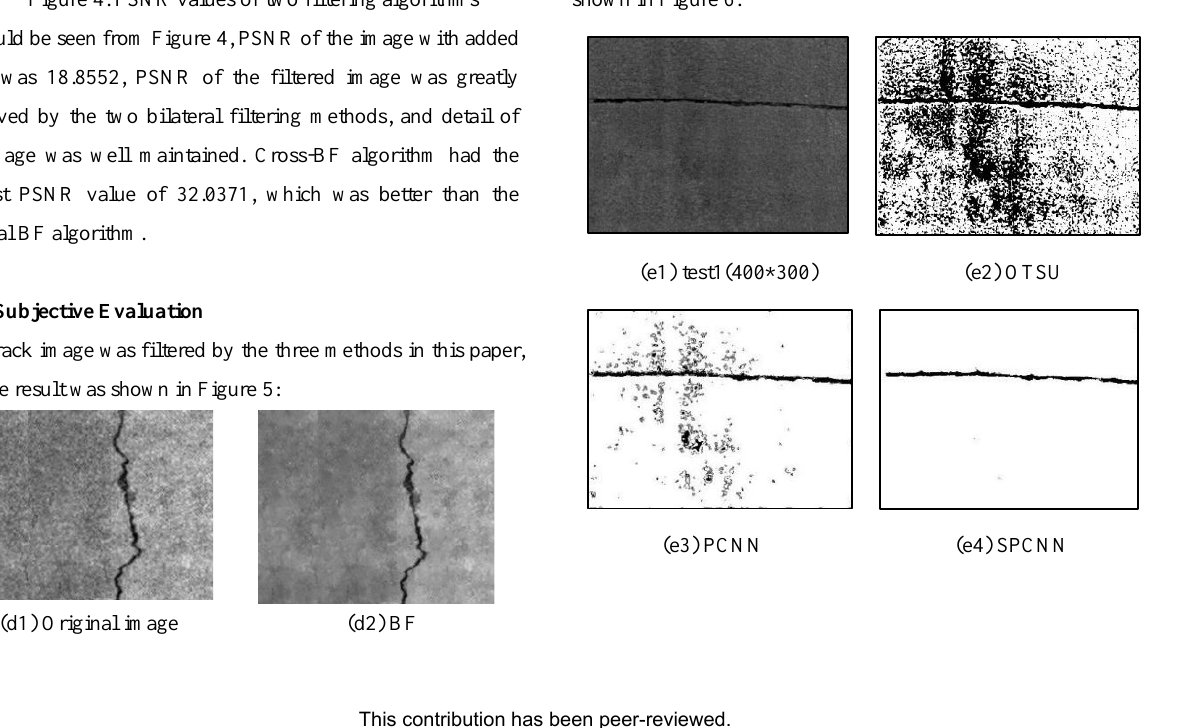
Figure 4. PSNR values of two filtering algorithms